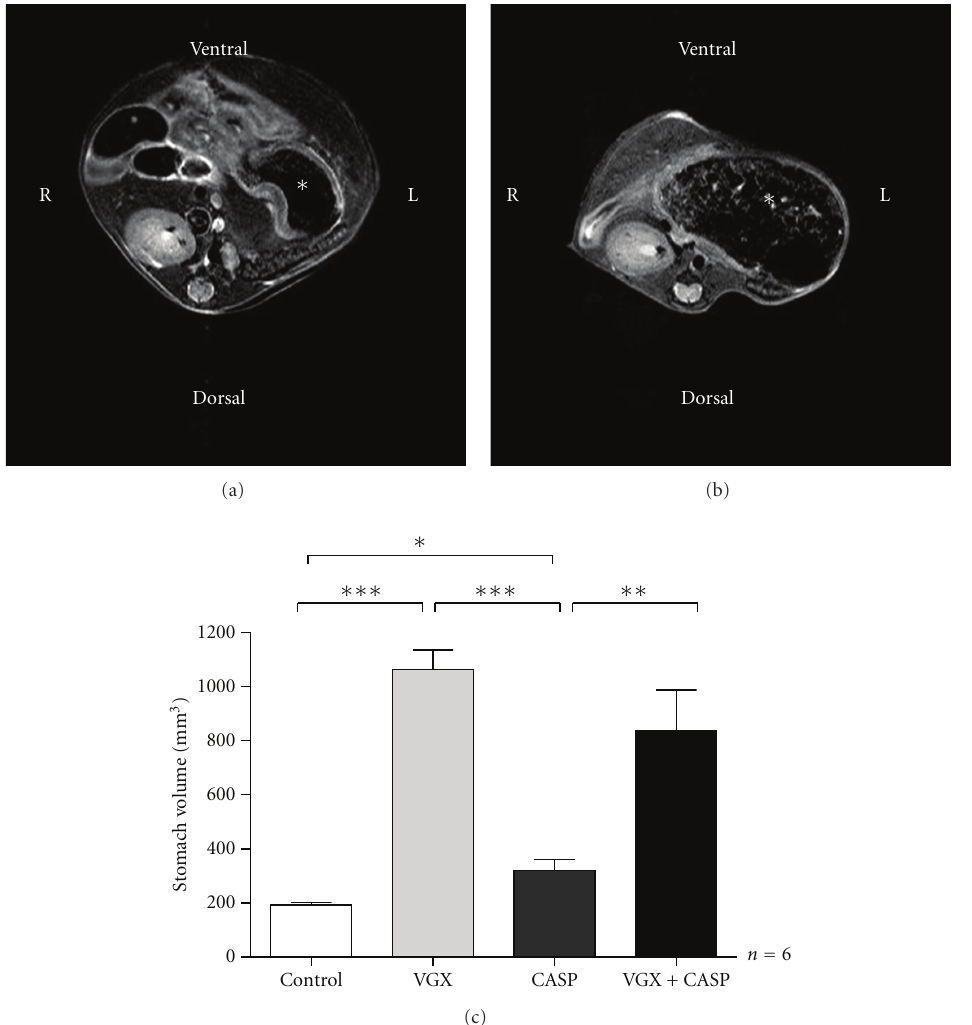
Figure 3: Images of MRI of the upper abdomen of mice. The asterisk identifies the stomach. Panel a shows the sectional image of an untreated mouse with normal gastric volume (a). Panel b displays the representative scan of a mouse with increased gastric volume after CASP and vagotomy (b). Values of gastric volume are shown in panel c. CASP alone led to a slight but significant increase of gastric volume. In both vagotomy groups, a strong dilatation of the stomach was measured that was independent from the presence of sepsis (c). ( n = 6 per group, ∗ P < 0 . 05, ∗∗ P < 0 . 01, and ∗∗∗ P < 0 .